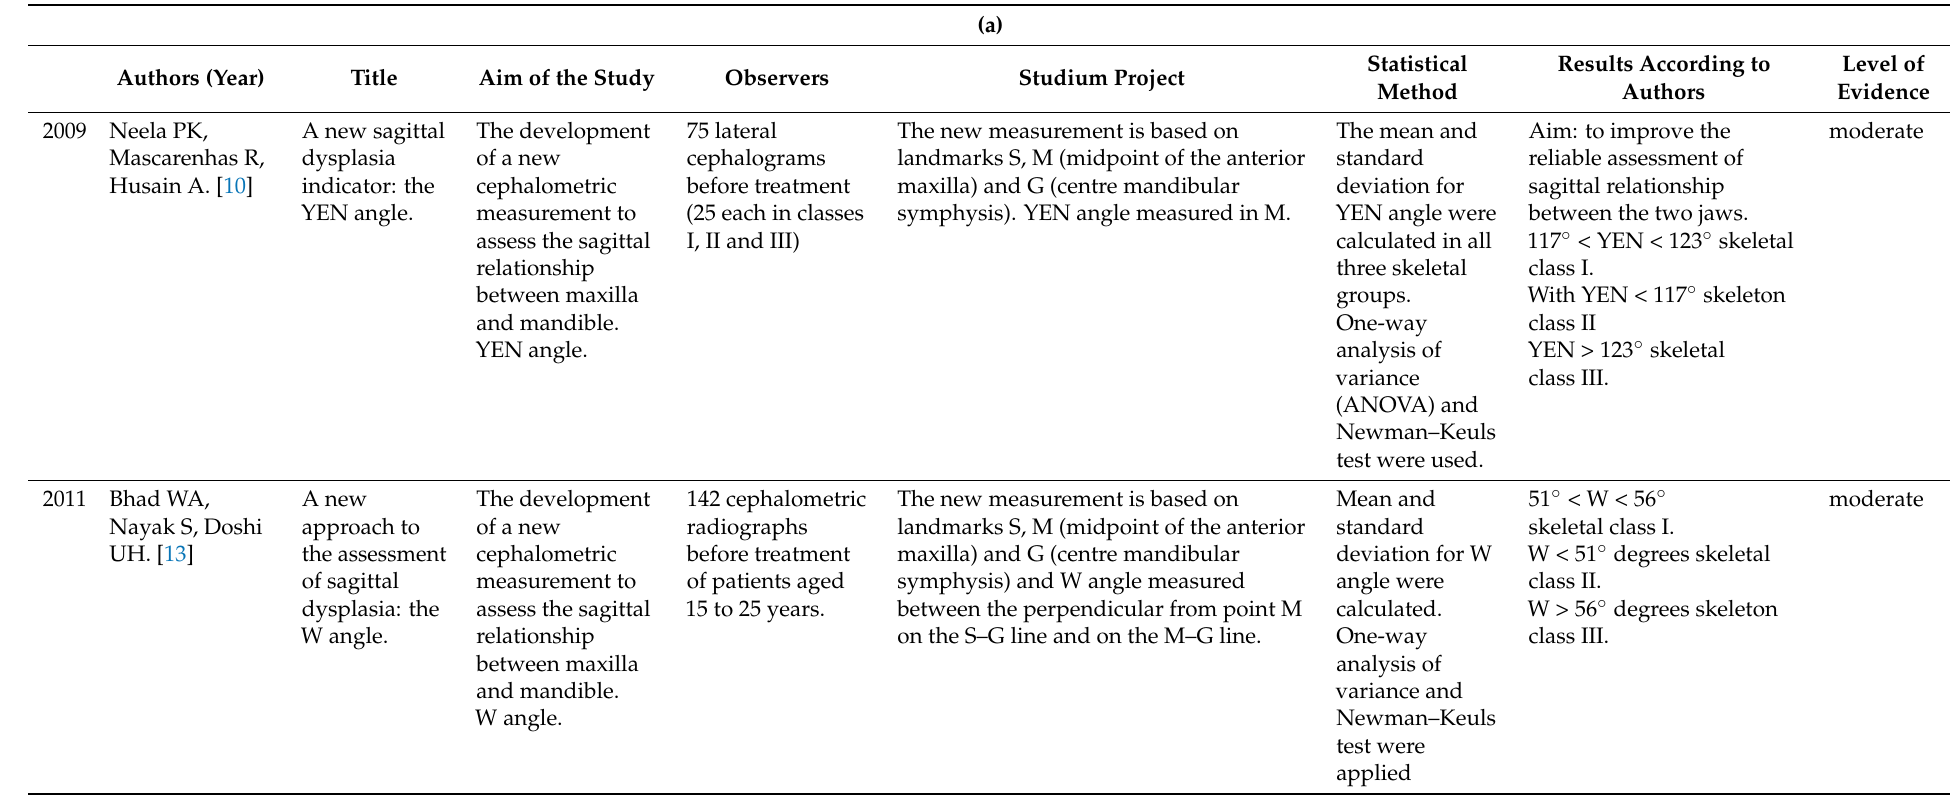
Table 4. ( a ) Publication analysis of parameters in sagittal discrepancy analysis. ( b ) Publication analysis of parameters in vertical discrepancy analysis.